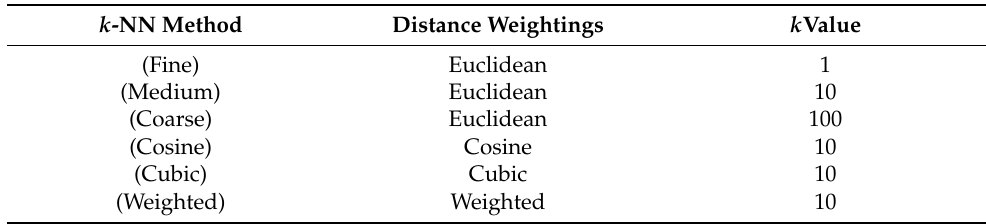
Table 3. k -NN method parameters. k -NN